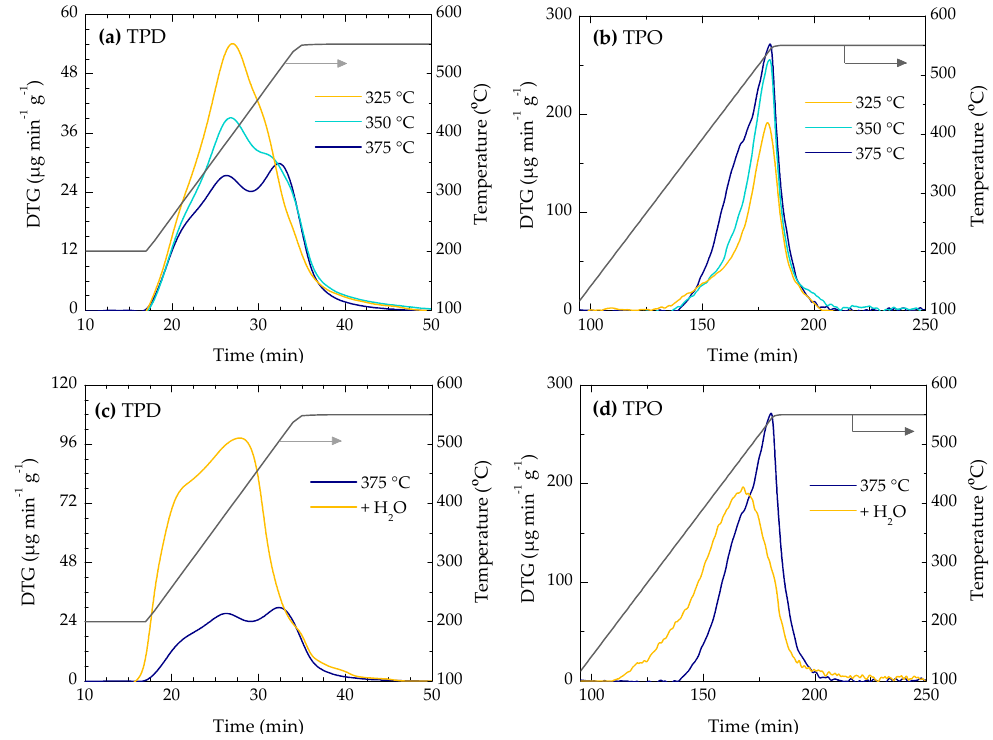
Figure 3. ( a ) TPD profiles under N 2 flow and ( b ) TPO profiles of deactivated catalysts at 325, 350 and 375 °C. Effect of co ‐ feeding water on the ( c ) TPD and ( d ) TPO profiles of the deactivated catalyst at 375 °C.